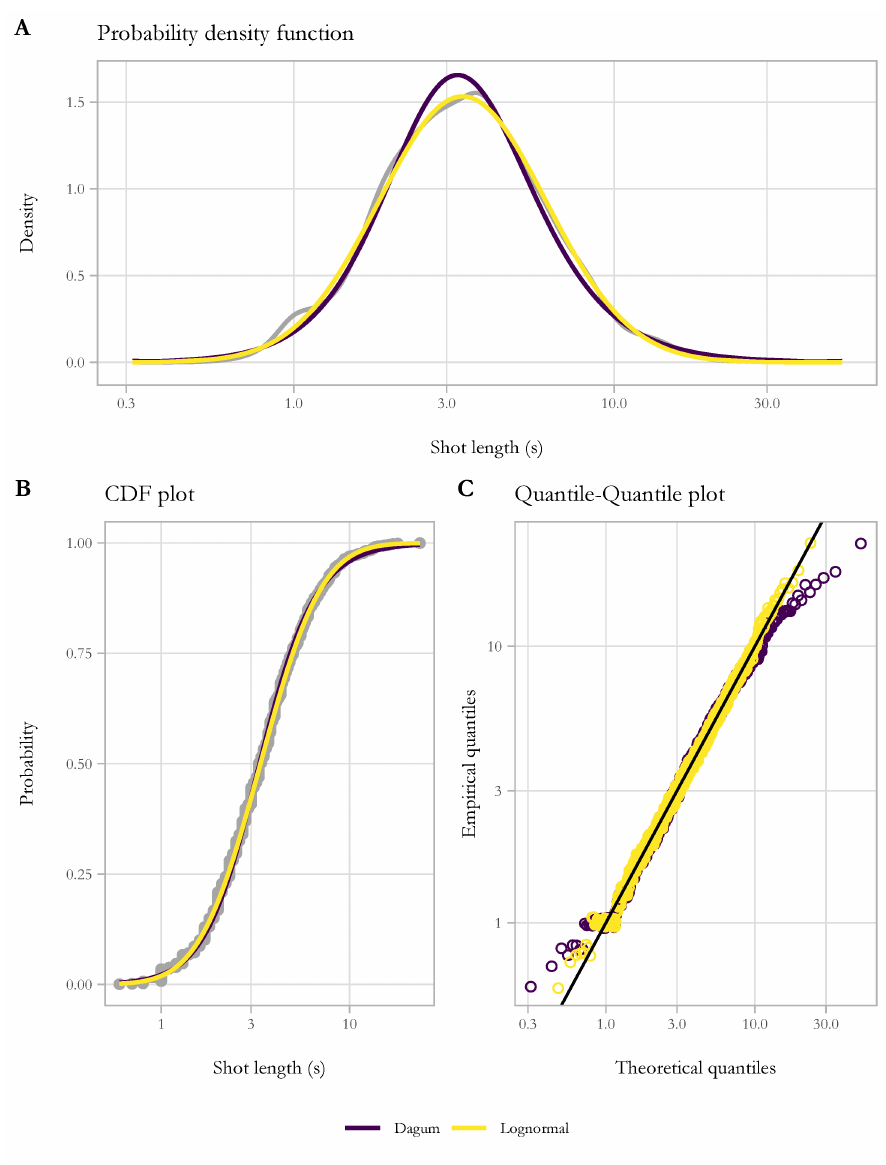
Figure 5 – Probability density function (A), cumulative distribution function (B) and quantile- quantile (C) plots for fitted three-parameter Dagum and two-parameter lognormal distributions for The Aristocats